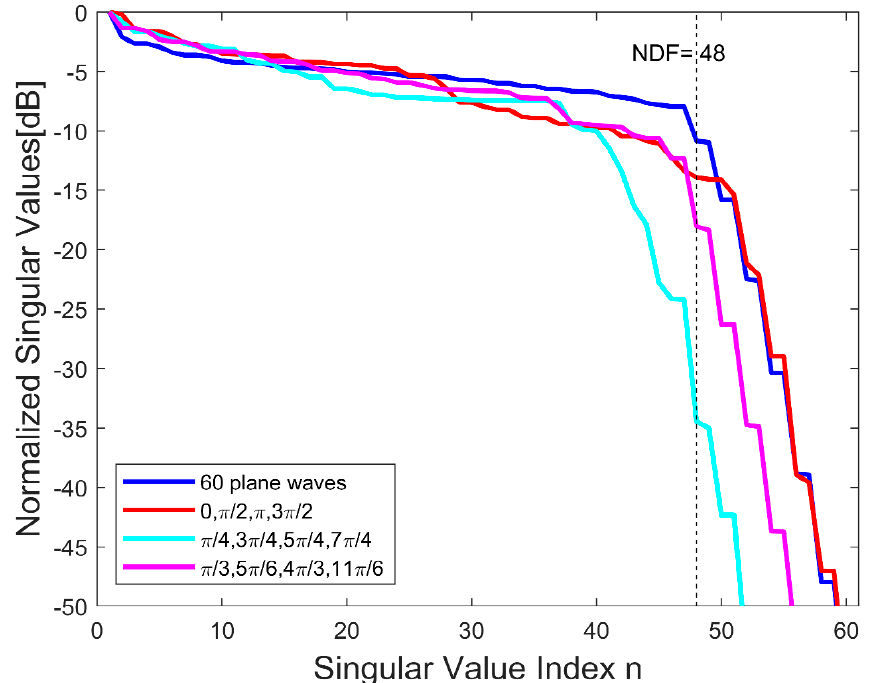
Figure 13. Normalized singular values of (26) for different directions of the impinging plane waves.